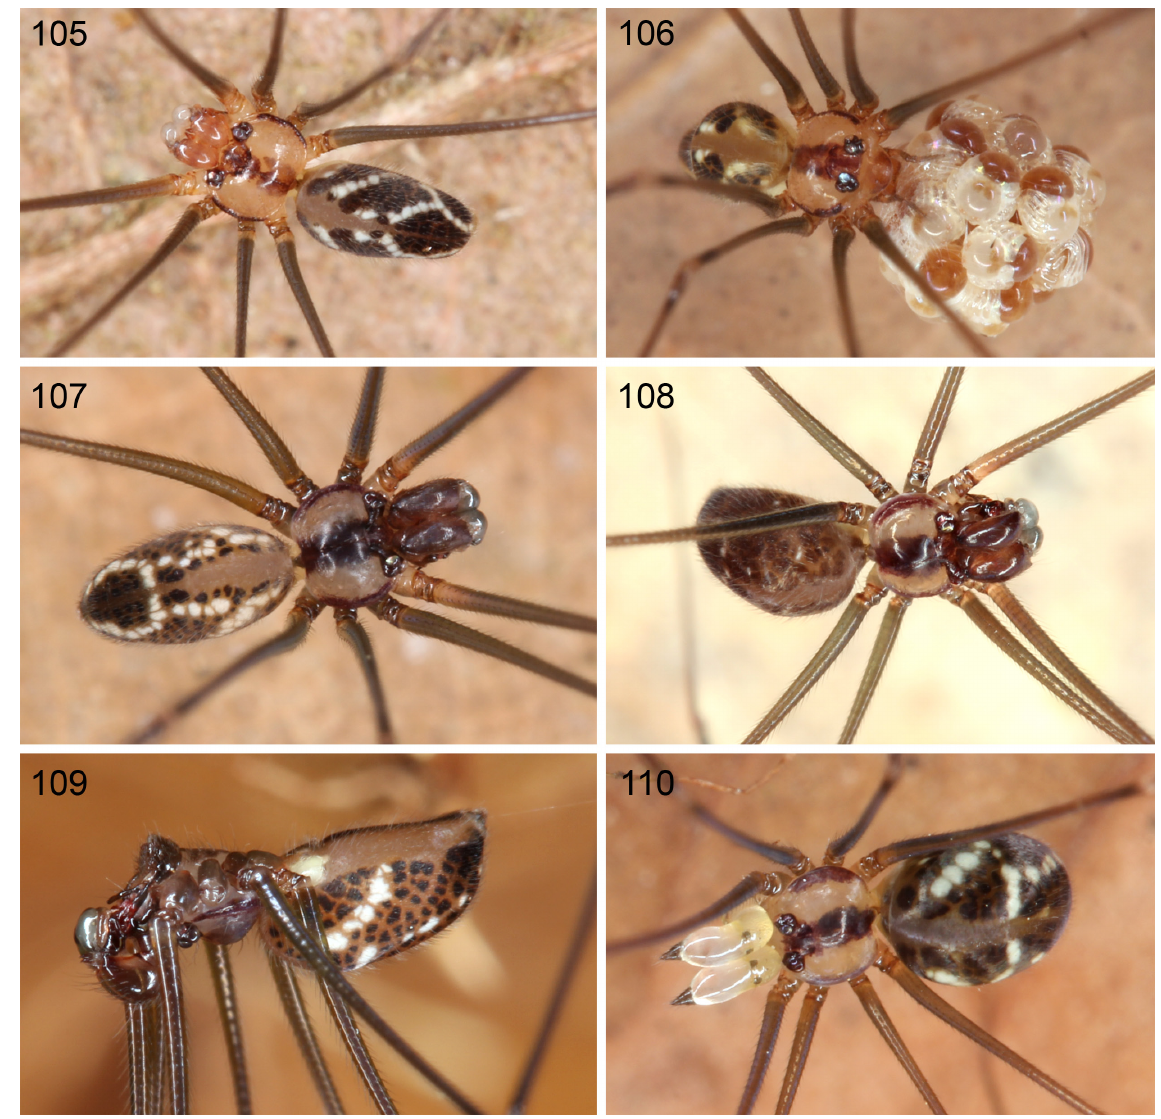
Figs 105–110. Live specimens. Aetana kinabalu group. — 105–106 . A. lambir Huber, sp. nov., ♂ and ♀ with eggsac from Lambir, Sarawak. — 107–108 . A. poring Huber, sp. nov., ♂♂ from Mt. Kinabalu, Sabah. — 109– 110 . A. indah Huber, sp. nov., adult and penultimate instar, ♂♂ from Crocker Range,